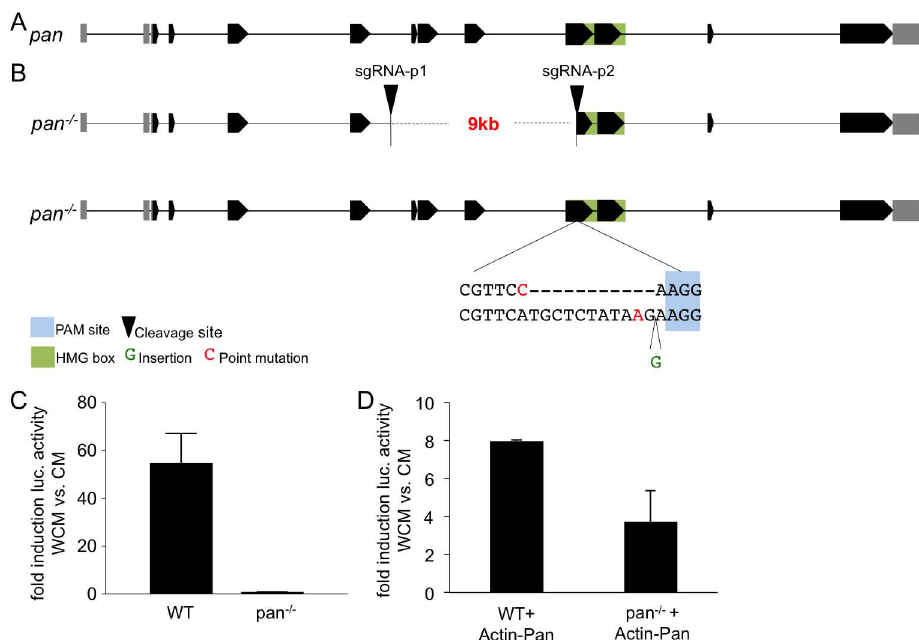
Fig 4. Mutagenesis of the pan gene. (A) Schematic of the pan gene-locus. Untranslated regions (UTR) are indicatedin grey boxes, translatedexonsin black. HMG box in green. (B) CRISPR targetingstrategy: Target sites of both sgRNAs are represented by black triangles.The PAM site is highlightedin blue, the HMG box in green.Sequencesas they are present in the pan -/–AF1AD26 (pan -/- ) cells are depictedbelow.(C) Wild-type(WT) and pan -/–AF1AD26 (pan -/- ) cells were transfectedwith the wingful luciferasereporter expression vector and Renillaexpressionvector 24 h prior stimulationwith WCM (as controlCM was used). After 24h stimulation, reporteractivity was analyzed.(D) Wild-type (WT) and pan -/–AF1AD26 (pan -/- ) cells were transfectedwith Pangolinoverexpression vector under the control of the Actin promotertogetherwith wingful luciferasereporter expression vector andRenillaexpression vector 24 h prior stimulation with WCM (as control CM was used). After 24h stimulation, reporter activity was analyzed.